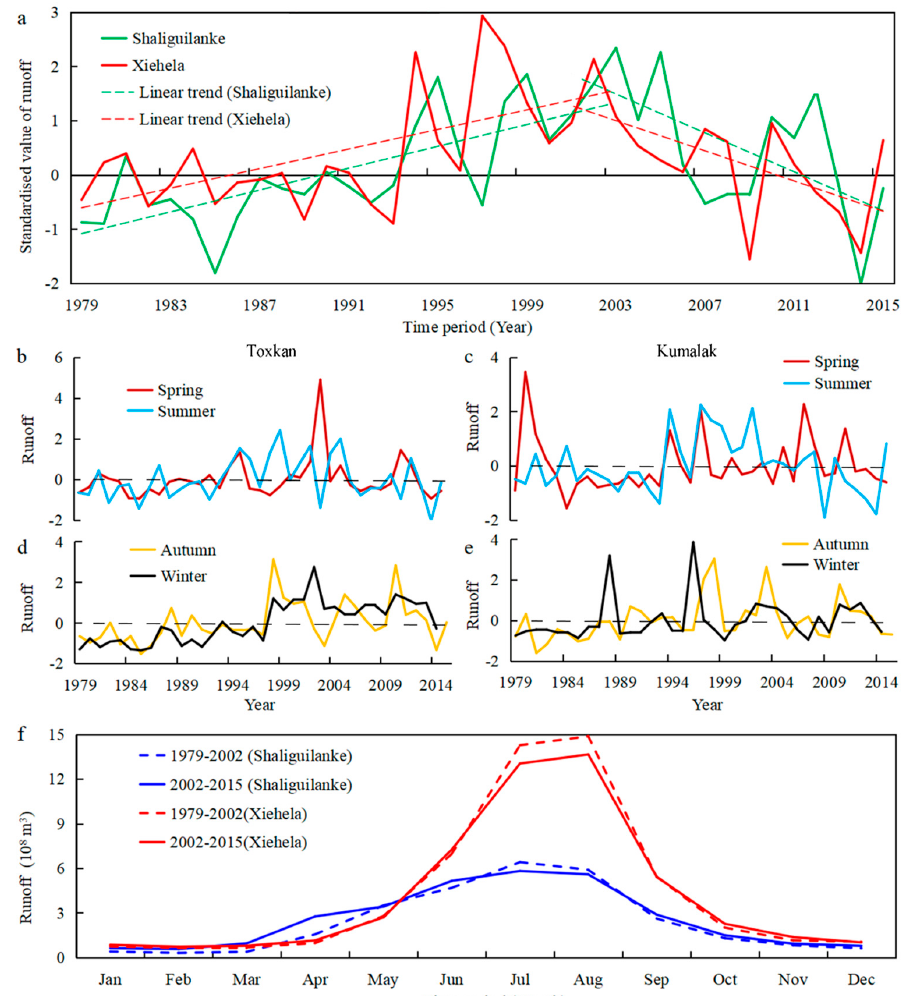
Figure 2. Runoff variations for Shaliguilanke station on the Toxkan River and Xiehela Station on the Kumalak River during 1979–2015. ( a ) Variations of standard values of annual runoff for the Toxkan and Kumalak Rivers during 1979–2015; ( b , d ) seasonal variations of Toxkan River’s runoff; ( c , e ) seasonal variations of Kumalak River’s runoff; ( f ) average seasonal cycle of runoff for Toxkan and Kumalak Rivers during 1979–2015.